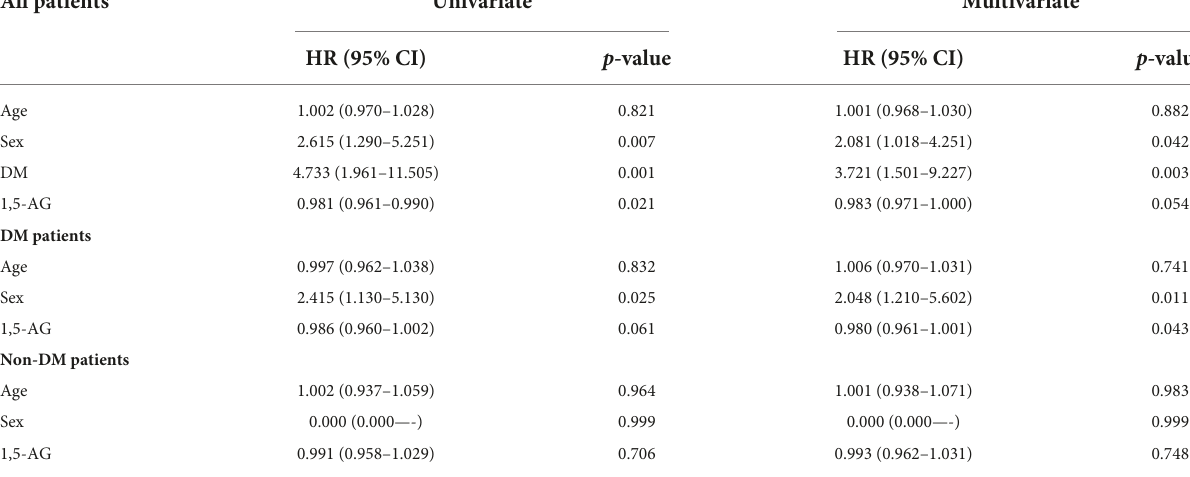
TABLE 4 Cox regression analysis for long-term MACE in enrolled patients stratified by DM. All